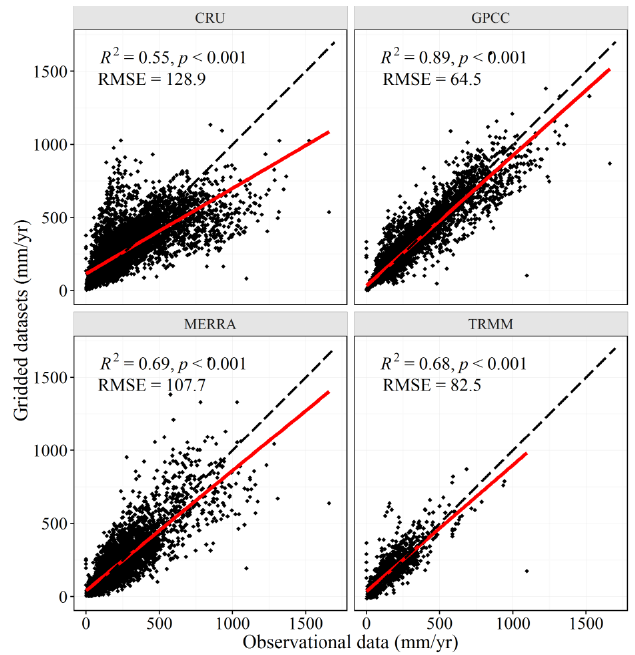
Figure 6. Validations of the four gridded datasets against observational data.